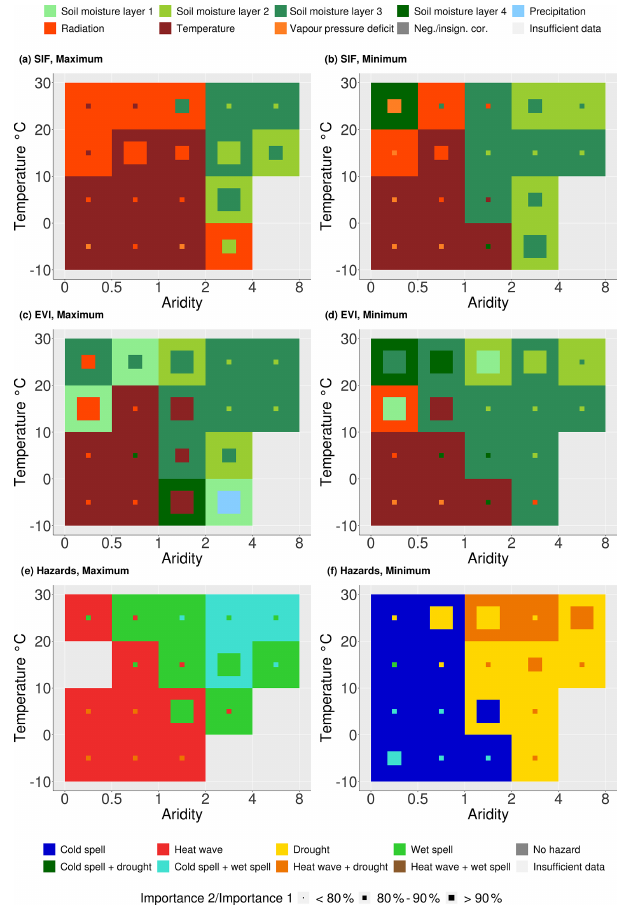
Figure 5. Hydrometeorological controls of vegetation productivity extremes summarized across climate regimes: (a, b) Sun-induced chlorophyll fluorescence (SIF) extremes and (c, d) enhanced veg- etation index (EVI) extremes. (e, f) Hydrometeorological hazards co-occurring with the SIF extremes. Box colour denotes the main controlling hydrometeorological variable; the second most impor- tant variable is indicated in the smaller squares’ colour, while its size represents the ratio between the highest and second highest number of grid